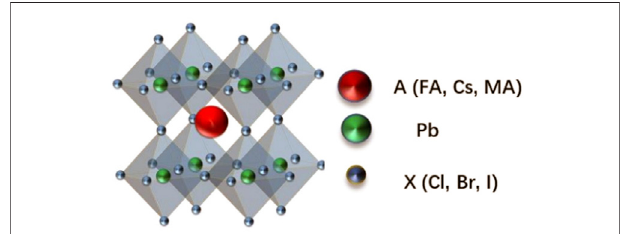
FIGURE 1 | The crystal structure of perovskite